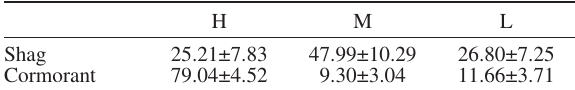
Table 6. – Proportion (%; mean±standard error) of fish with high (H), medium (M) and low (L) commercial value preyed on by shag and cormorant. H M L